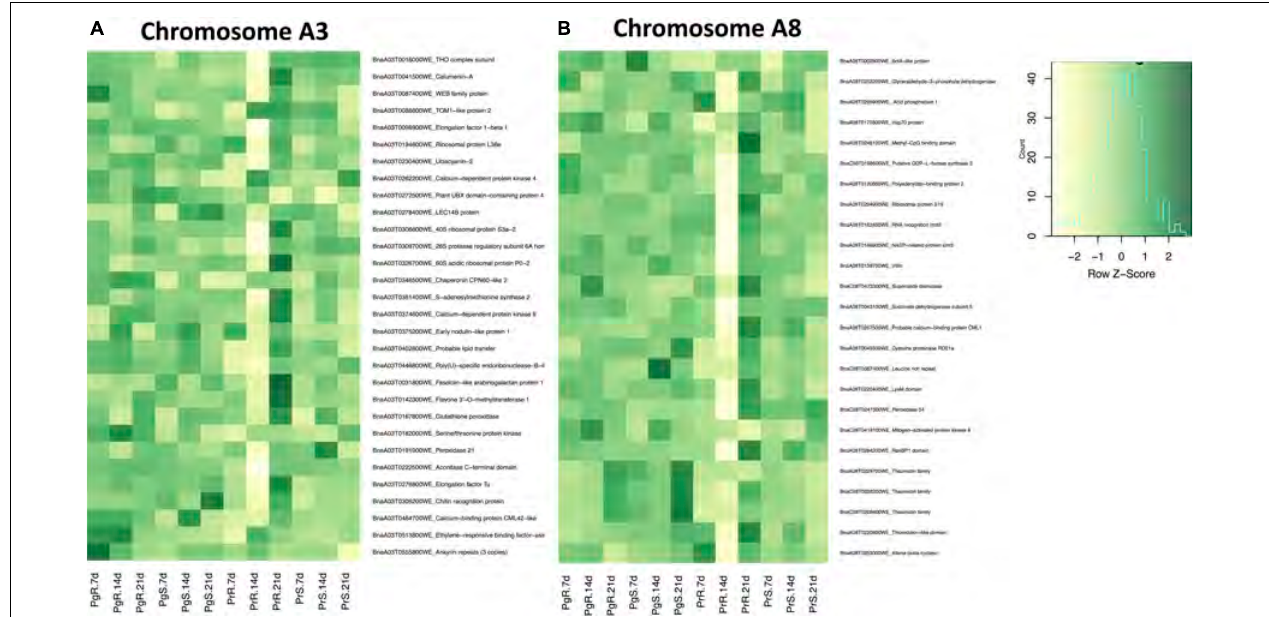
FIGURE 8 | Differentially accumulated proteins (DAP) at all three time points between control (CC) and inoculated (In) lines, In/CC CS and In/CC CR lines across parent and progeny, these proteins are from (A) chromosome A3 and (B) A8. Heatmaps were developed using log 2 fold change values at 7-, 14-, and 21-DPI. Dark Green indicates increase in abundance and light color indicates decrease in abundance. Proteins included in the heatmaps were significantly ( q -value < 0.05) differentially abundant at least in one time point across all genotypes investigated.